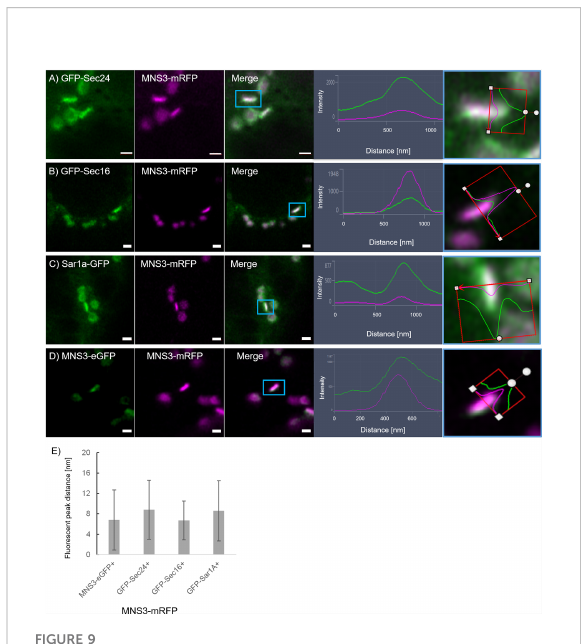
FIGURE 9 The ERES markers localize at the GECCO. ERES markers GFP- Sec24 (A) , GFP-Sec16 (B) and Sar1a-GFP (C) colocalize with MNS3-mRFP. (D) MNS3-eGFP and MNS3-mRFP are coexpressed as a control for full colocalization. Representative confocal images and analysis plots are shown for each combination. The blue box indicates the Golgi body shown enhanced on the right- hand side panels (merged images in side view together with line pro fi les for both markers). Proteins are expressed transiently in tobacco leaf epidermal cells. Size bars = 1 µm. (E) Statistical analysis shows the distance [nm] between fl uorescent peak of ERES marker and MNS3-mRFP. Signi fi cance was analyzed by Kruskal-Wallis. n = 3 with 5 technical replicas each.